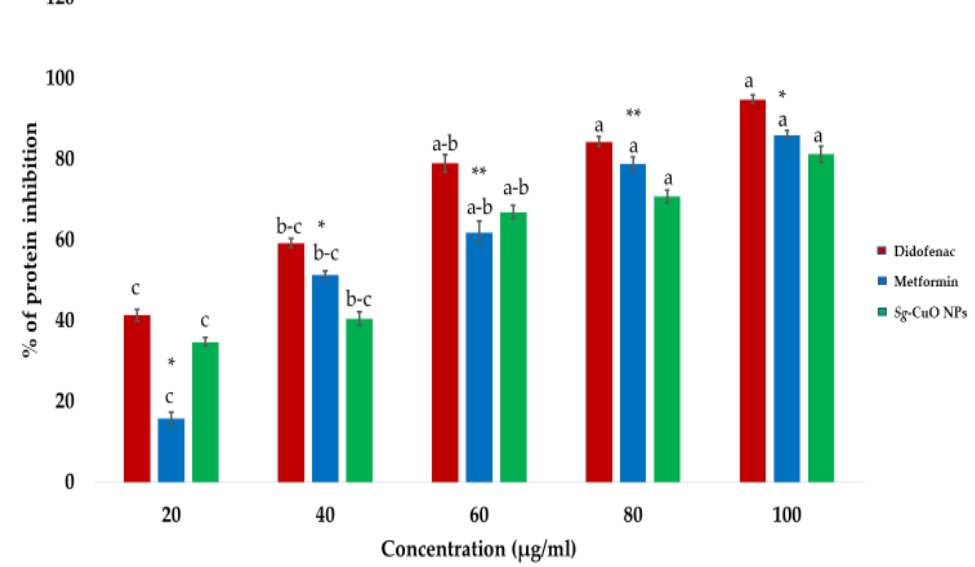
Figure 8. Egg albumin degradation test for protein degradation with Sg -CuO NPs (20–100 µ g/mL) against the positive controls metformin (20–100 µ g/mL) and diclofenac (20–100 µ g/mL). Values expressed in mean ± SD, ANOVA followed by Tukey’s post hoc, which showed a significant level at p -value * < 0.001, ** < 0.05 (Lowercase le tt ers).